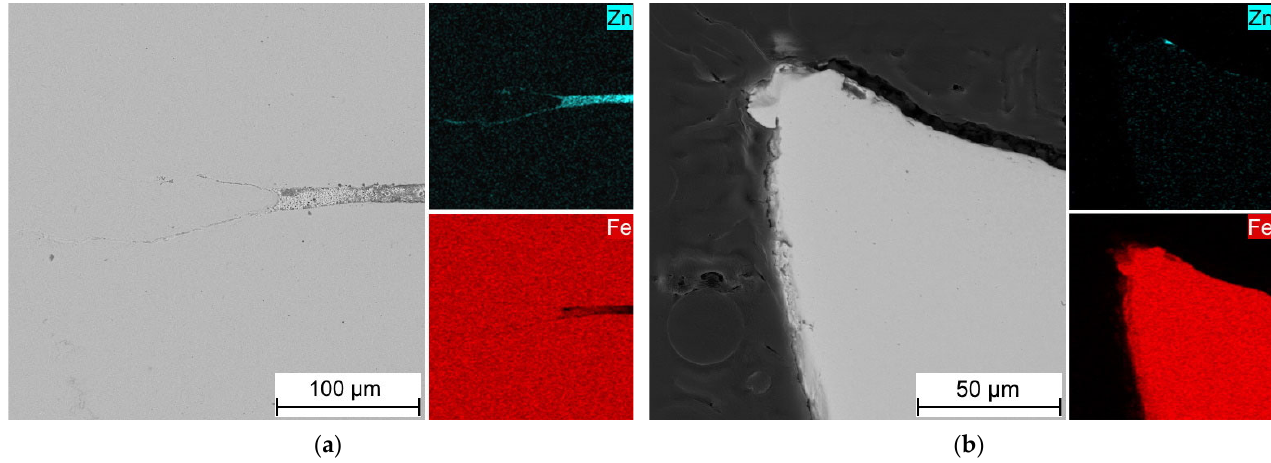
Figure 11. SEM details of magnified weld notch B (Figure 10) showing the branches filled with a thin layer of Zn coating ( a ) and the fracture cross section A (Figure 8b) without any traces of Zn ( b ).